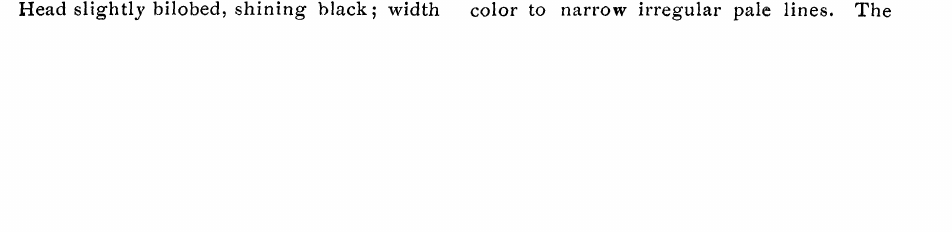
7 mm. Body pale yellow dorsally on joints 3 to I2 with three faint purplish lines; cervi- cal shield and anal plate smoky; a central purple spot on joints 5 and I2, the latter joint a little enlarged. A sub-dorsal, purple- brown mottled line and faint mottlings on the sides; feet and leg plates dusky. Hairs pale, some of them long. Later the pale parts predominate so that the body appears multilineate with pale, the warts yellow. Stage IlL Width of head t.t mm. Stage IV. Head bilobed, shining black with many soft white hairs; medium suture deep, clypeus small, triargular, sunken below the bulging lobes; width, 2 mm. The body appeat:s as before a whitish ground, trav- ersed by faint triple dorsal, triple approxi- mate lateral and double stigmatal broken, narrow, purplish brown bands, the dorsal , ones fainter than the others. Central dorsal spots behind tubercle on joints 5 and brown, no humps; warts all yellow. Pri- mary and secondary hairs soft, pale, not long. Stage V. Head black, the broad, high clypeus pale, scarcely sunken width 3. mm. Body as before, the dorsal patches on joints 5 and t2 much fainter; warts conspicuously yellow. The pale brown mottled lines are broader than the five inteYvening spaces on each side, mottled, pulverulent on a dirty whitish ground. A single example had the colors brighter, the lines red, "take red," the three dorsal fainter than the lateral ones; tubercles yellow, the lateral ones giv- ing the appearance of yellow lines alternat- ing with the lateral red ones (as in Dr. Packard’s description). Later as the larvae mature the head becomes nearly entirely black, the lines dark dull purple, broad, mottled and freckled, reducing the ground color to narrow irregular pale lines.